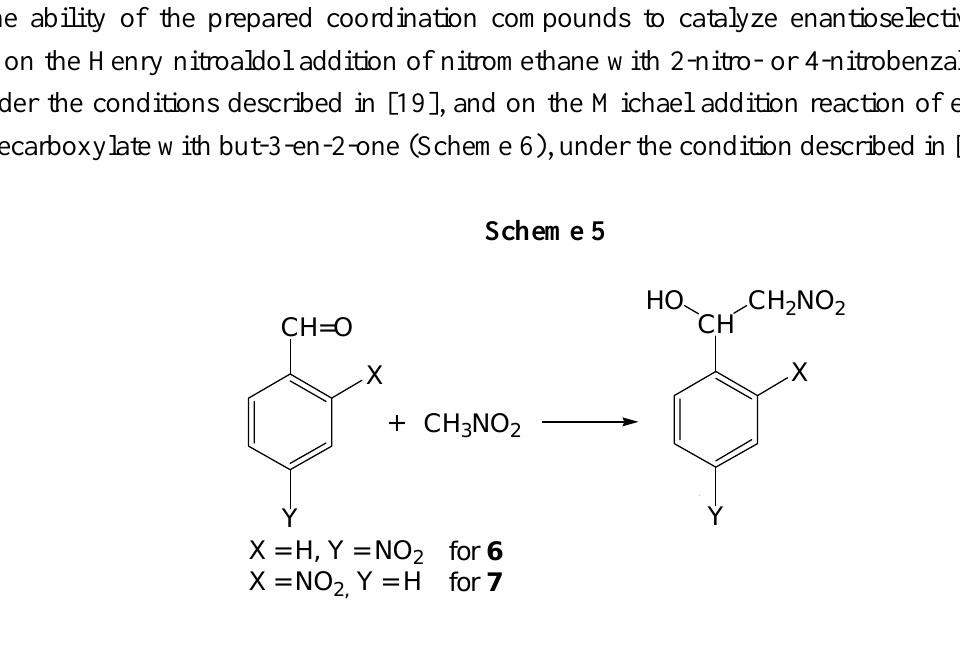
(Table 1). ( R )-2-Nitro-1-(2-nitrophenyl)ethanol ( 7 ) resulted in an enantiomeric excess of only 12.3